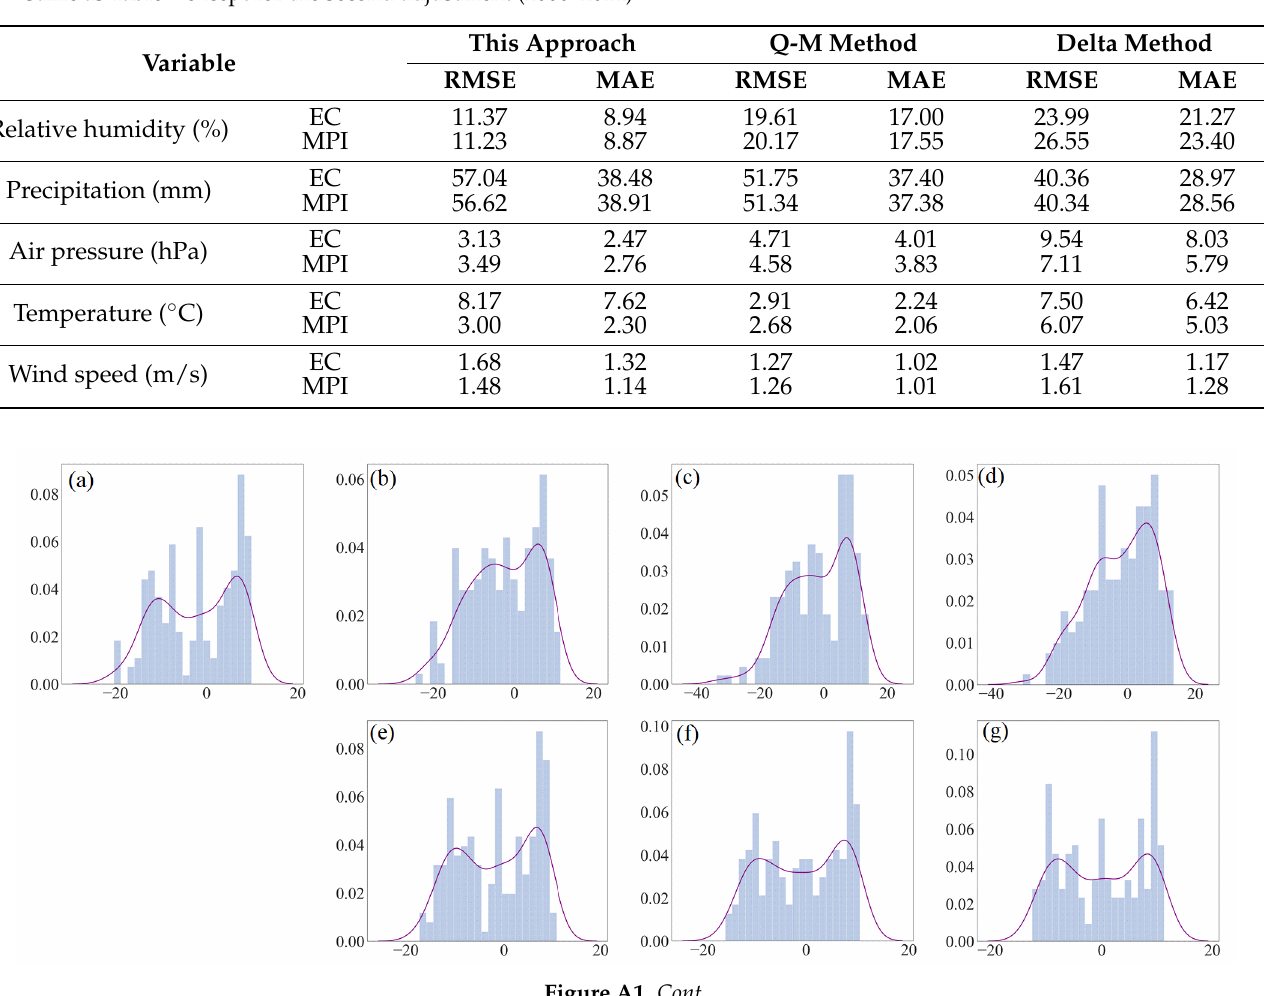
Figure A1. Changes in PDF during the successive adjustments of monthly air temperature based on the GCM MPI simu- lations at the Naqu site. The upper row indicates the control observations (( a ), 1955 – 1969)) and the calibrated results of the three adjustments ( b – d ). The center row ( e – g ) indicates the observations for validating the calibrated results for the corresponding projection periods. The bottom row ( h – k ) indicates the raw GCM simulations in the corresponding periods. The first column: control period (1955 – 1969); the second to fourth columns: the first (1970 – 1984), second (1985 – 1999) and third (2000 – 2014) adjustments, respectively. The solid line indicates a distribution fit to the data.